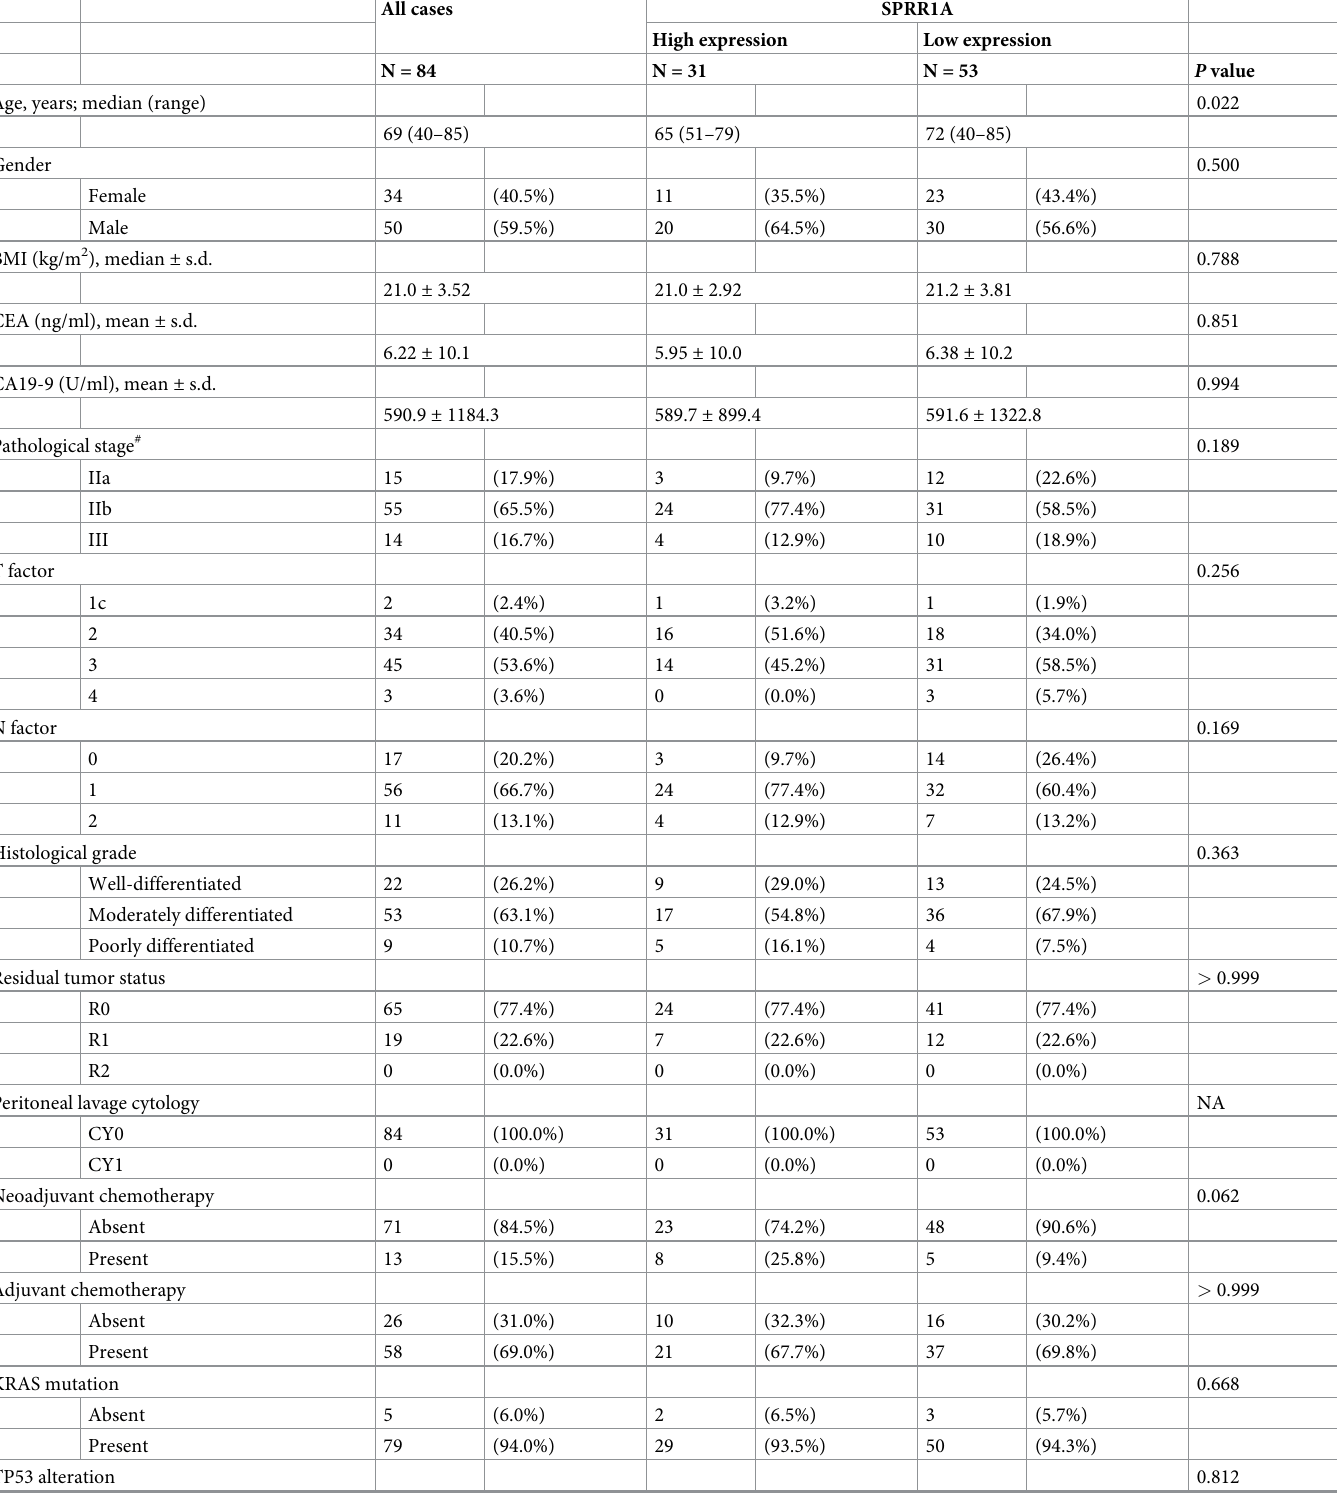
Table 1. Difference in patient characteristics between the high and low-SPRR1A-expression